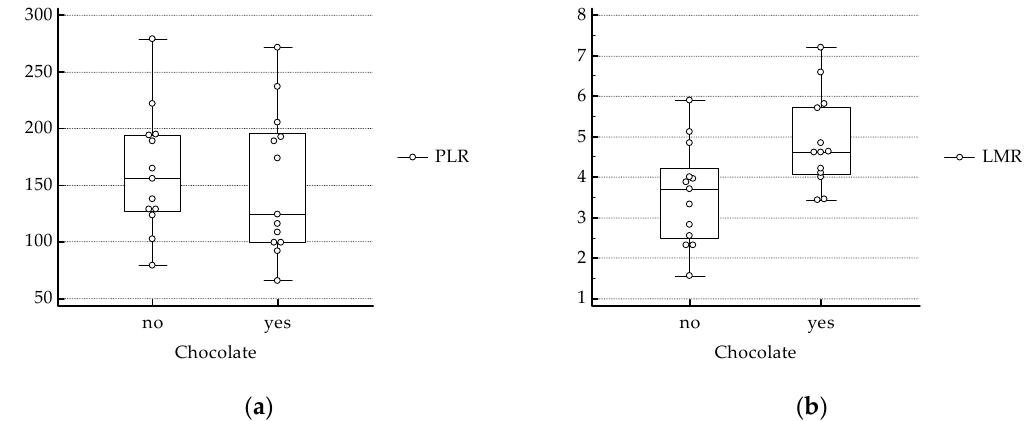
Figure 2. ( a ) PLR: platelet-to-lymphocyte ratio. No significant differences between chocolate consumers and non-consumers. ( b ) LMR: lymphocyte-to-monocyte ratio, Normality Test (Shapiro–Wilk) passed, two tailed T Test (chocolate yes versus no: p = 0.01).